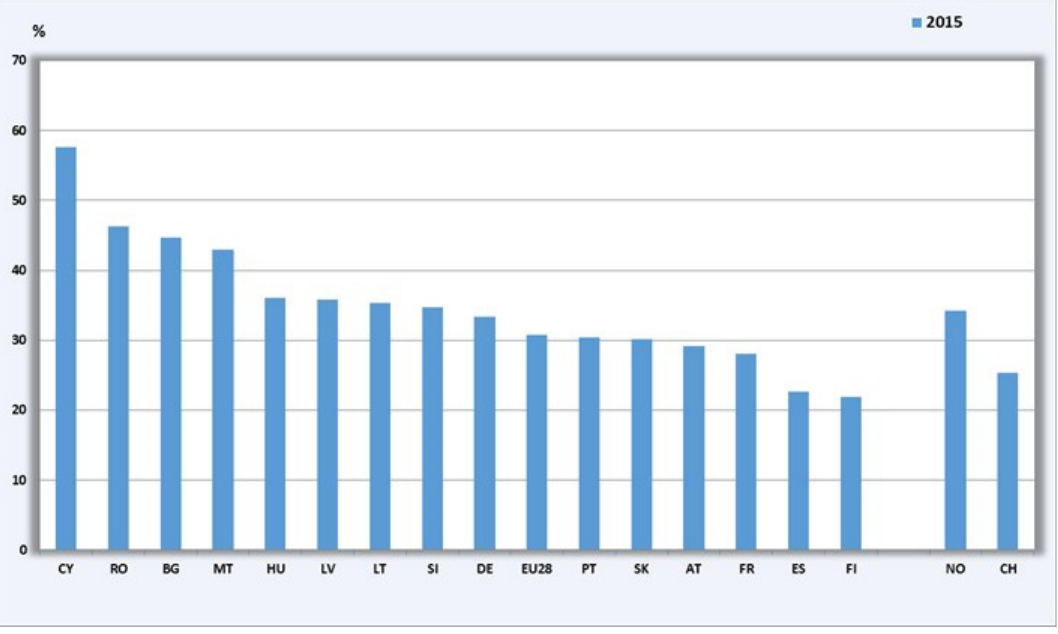
Figure 3. Percentage of VET STEM (science, technology, engineering and mathematics) graduates in 2015. Source: CEDEFOP calculations based on Eurostat data/UOE data collection on education.